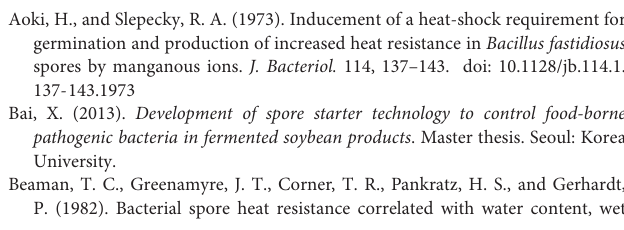
Supplementary Figure 1 | Linear regression of thermal survivor curves for B. licheniformis spores formed under diverse supplementation conditions. (A) Manganese 0.00 mM, (B) manganese 0.10 mM, (C) manganese 0.25 mM, and (D) manganese 0.50 mM. — : Calcium 0.00 mM, — : Calcium 0.25 mM, — : Calcium 0.50 mM, — : Calcium 1.00 mM, — : Calcium 2.00 mM. Each regression line was drawn based on survivor data obtained after treatment at 100 ◦ C for five different time intervals. Supplementary Figure 2 | Linear regression of thermal survivor curves for B. cereus spores formed under diverse supplementation conditions. (A) Manganese 0.00 mM, (B) manganese 0.10 mM, (C) manganese 0.25 mM, and (D) manganese 0.50 mM. — : Calcium 0.00 mM, — : Calcium 0.25 mM, — : Calcium 0.50 mM, — : Calcium 1.00 mM, — : Calcium 2.00 mM. Each regression line was drawn based on survivor data obtained after treatment at 100 ◦ C for five different time intervals. Supplementary Figure 3 | Linear regression of thermal survivor curves for B. coagulans spores formed under diverse supplementation conditions. (A) Manganese 0.00 mM, (B) manganese 0.10 mM, (C) manganese 0.25 mM, and (D) manganese 0.50 mM. — : Calcium 0.00 mM, — : Calcium 0.25 mM, — : Calcium 0.50 mM, — : Calcium 1.00 mM, — : Calcium 2.00 mM. Each regression line was drawn based on survivor data obtained after treatment at 100 ◦ C for five different time intervals. Supplementary Figure 4 | Linear regression of thermal survivor curves for B. subtilis spores formed under diverse supplementation conditions. (A) Manganese 0.00 mM, (B) manganese 0.10 mM, (C) manganese 0.25 mM, and (D) manganese 0.50 mM. — : Calcium 0.00 mM, — : Calcium 0.25 mM, — : Calcium 0.50 mM, — : Calcium 1.00 mM, — : Calcium 2.00 mM. Each regression line was drawn based on survivor data obtained after treatment at 100 ◦ C for five different time intervals. Supplementary Figure 5 | Heat resistance profiles of B. licheniformis spores formed under diverse supplementation conditions. Bars and error bars represent means and standard deviations, respectively, calculated from triplicate experiments. The gray and black bars indicate the lowest and highest D 100 ◦ C -values, respectively. Supplementary Figure 6 | Heat resistance profiles of B. cereus spores formed under diverse supplementation conditions. Bars and error bars represent means and standard deviations, respectively, calculated from triplicate experiments. The gray and black bars indicate the lowest and highest D 100 ◦ C -values, respectively. Supplementary Figure 7 | Heat resistance profiles of B. coagulans spores formed under diverse supplementation conditions. Bars and error bars represent means and standard deviations, respectively, calculated from triplicate experiments. The gray and black bars indicate the lowest and highest D 100 ◦ C -values, respectively. Supplementary Figure 8 | Heat resistance profiles of B. subtilis spores formed under diverse supplementation conditions. Bars and error bars represent means and standard deviations, respectively, calculated from triplicate experiments. The gray and black bars indicate the lowest and highest D 100 ◦ C -values,